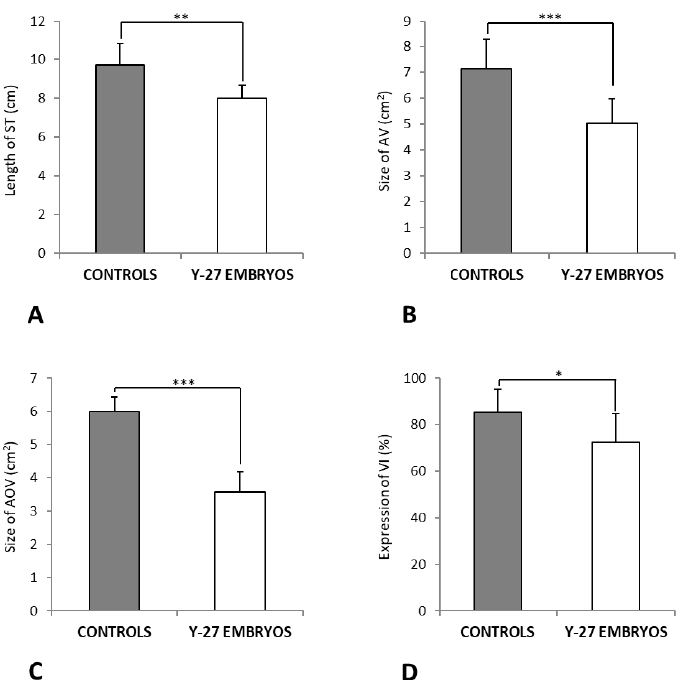
Figure 5. Measurements of EEM formation at 60 + 24 h. There was a significant difference in the mean length of ST ( A , ** p = 0.001), mean size of AV ( B , *** p < 0.001), mean size of AOV ( C , *** p < 0.001), and mean VI ( D , * p < 0.05) between controls and Y-27632 (500 µM)-treated embryos. The vertical bars represent the SD. y-axis : Length of ST in cm ( A ), Size of AV and AOV in cm 2 ( B , C ), and Expression of VI in % ( D ).